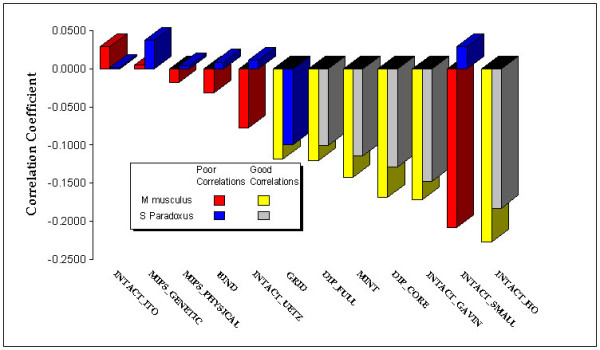
Dataset Correlations. The bar graph shows the Spearman's rank correlation coefficients observed between number of interactions and evolutionary rate. Evolutionary rate was estimated using two sets of orthologs, from M musculus and S paradoxus. Good correlations all had low P-values (< 0.03) while the poor correlations had high P-values > 0.03. Where P-values were significant, correlations using S paradoxus orthologs were slightly weaker, yet the general magnitude followed the same trend shown by the correlations obtained using M musculus orthologs.